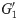
Responses of DSD realized naive implementations to a step input of amplitude 10−6 nM under different values of parameter a.(A) Responses of G1′ under a = 0.5, 1.0, 1.5. (B) Responses of G1′ under a = 4.0, 5.0, 6.0. (C) Responses of G2′ under a = 0.5, 1.0, 1.5. (D) Responses of G2′ under a = 4.0, 5.0, 6.0. (E) Responses of G3′ under a = 0.5, 1.0, 1.5. (F) Responses of G3′ under a = 4.0, 5.0, 6.0.